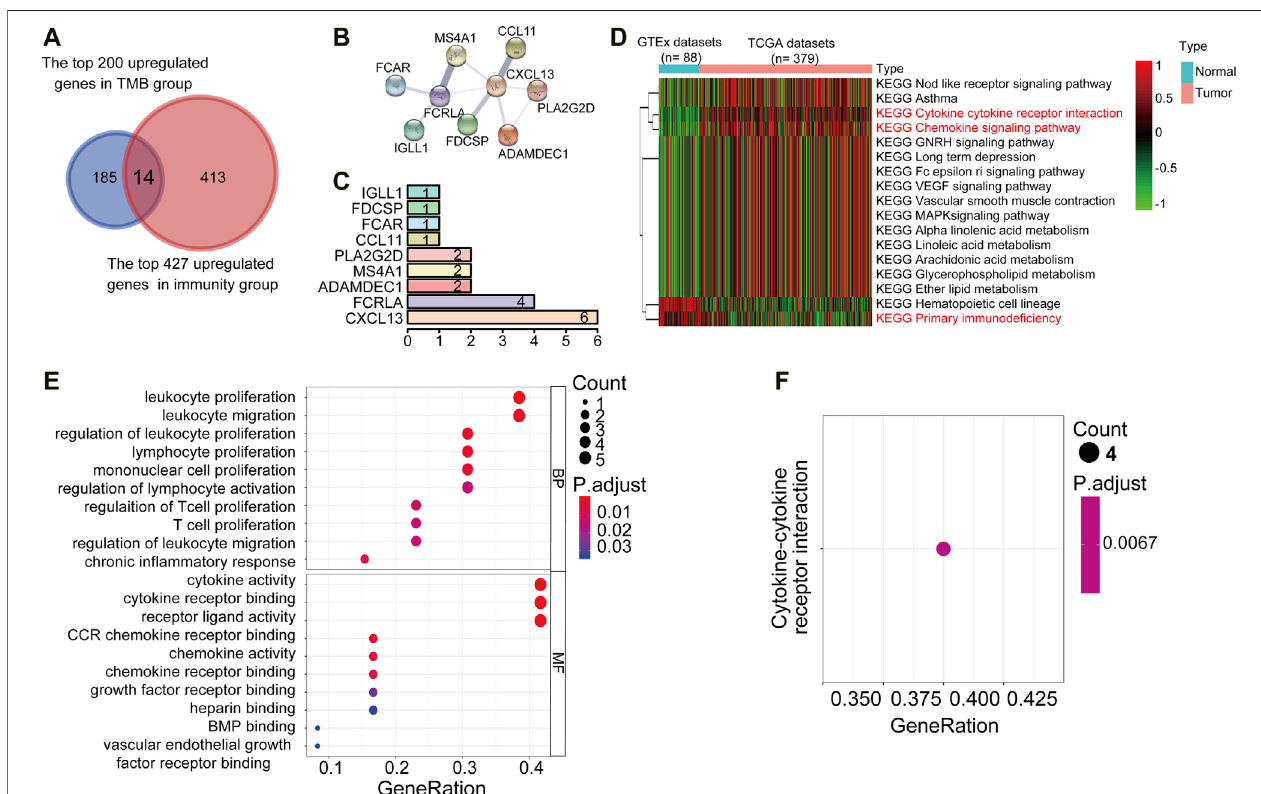
FIGURE 3 | PPI networks, KEGG pathway, and GO term analysis of Up-DEGs. (A) Venn diagrams displayed the amount of conjointly Up - DEGs in both TMB high group and immunity high group. (B) PPI network established by the STRING database for the Up-DEGs module. (C) Quanti fi cation diagram of the Up-DEGs module. (D) Unsupervised hierarchical clustering of KEGG pathways associated with 14 Up-DEGs. Blue represents normal samples, data from GTEx ( n (cid:1) 88), red represents OC samplesfrom theTCGA dataset ( n (cid:1) 379). Theaveragelinkage method and thePearsondistancemeasurementmethod wereused to depictthe Heatmaps. High expression genes are shown in red, low expression genes in green, and genes with the same level of expression are shown in black. False discovery rate (FDR) < 0.05, foldchange > 1. (E,F) EnrichedGOandKEGGpathwaysof14Up-DEGsbyusingRsoftware.The X -axisservesastheproportionofrelevantgenes,andthe Y -axisserves as the GO and KEGG terms. Each bubble means a term. The size of the bubble implies the account of relevant genes. Lighter colors suggest the smaller p values. (E) : Enriched GO terms. (F) : Enriched KEGG terms. FDR of GO and KEGG pathway analysis was acquired from the DAVID functional annotation tool. p <